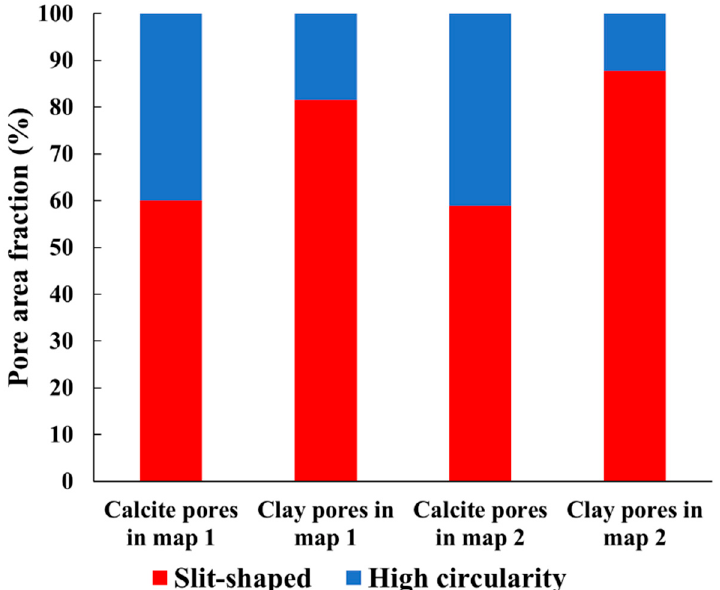
Figure 7. Area fractions of slit-shaped and high-circularity pores in calcite and clay mineral phases